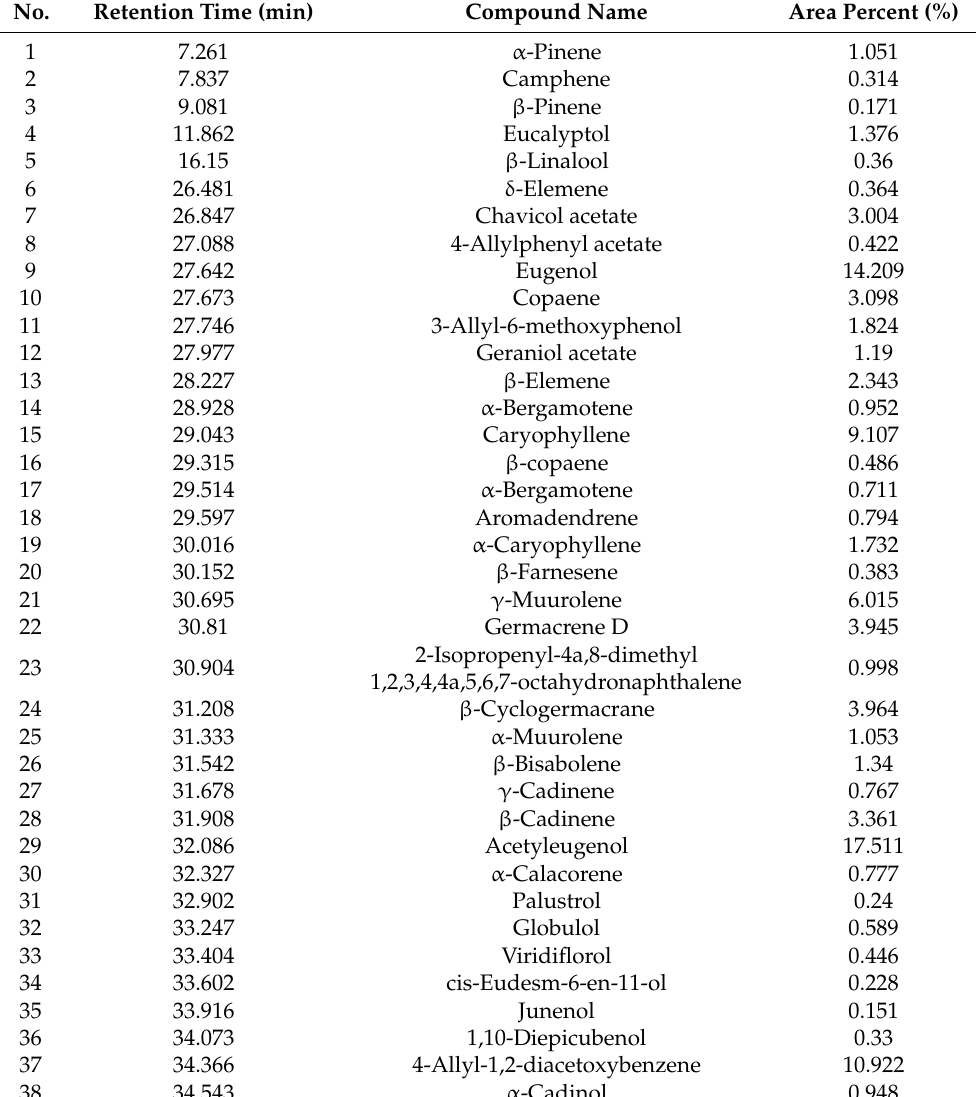
Table 1. Chemical composition of Piper betle Linn. leaf